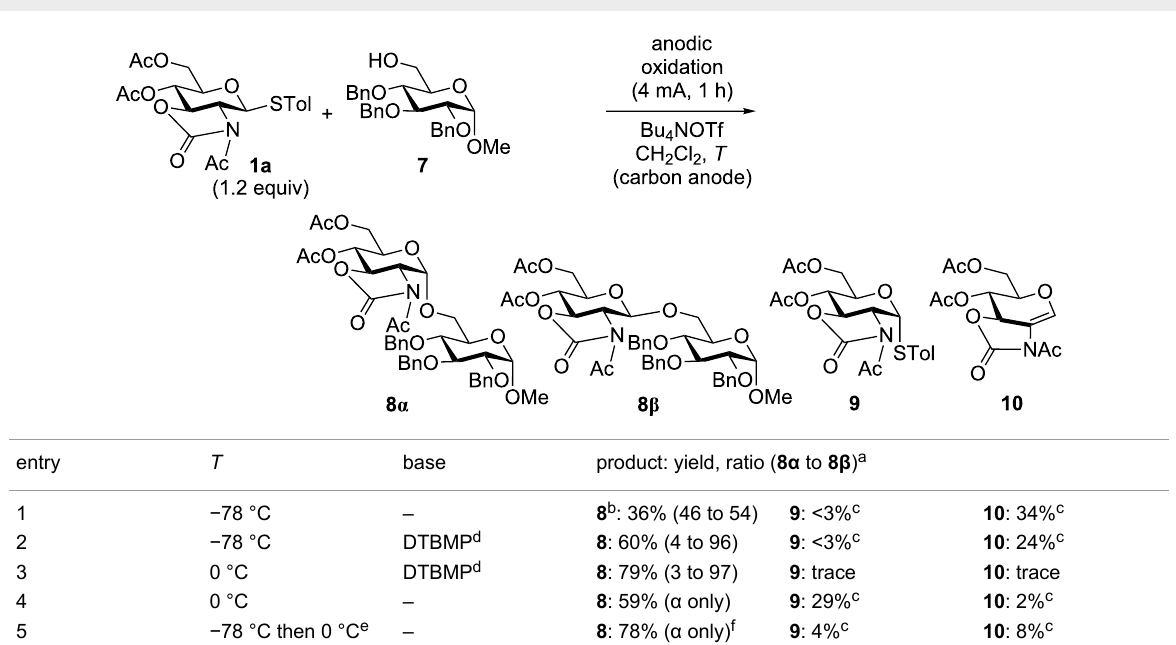
Table 3: Electrochemical glycosylation in the presence of glycosyl acceptor.